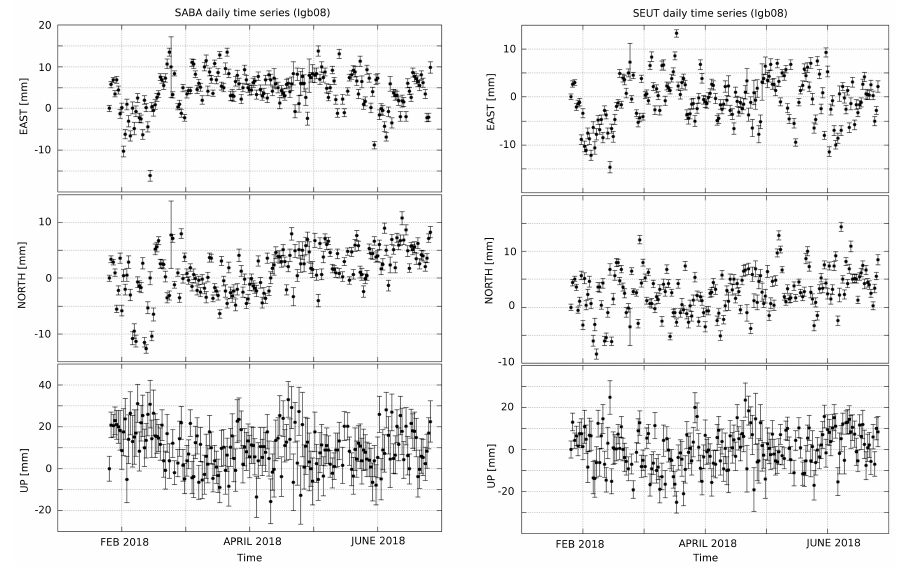
Figure 13. Time series showing the east, north, and vertical components of GNSS stations SABA ( left ) and SEUT ( right